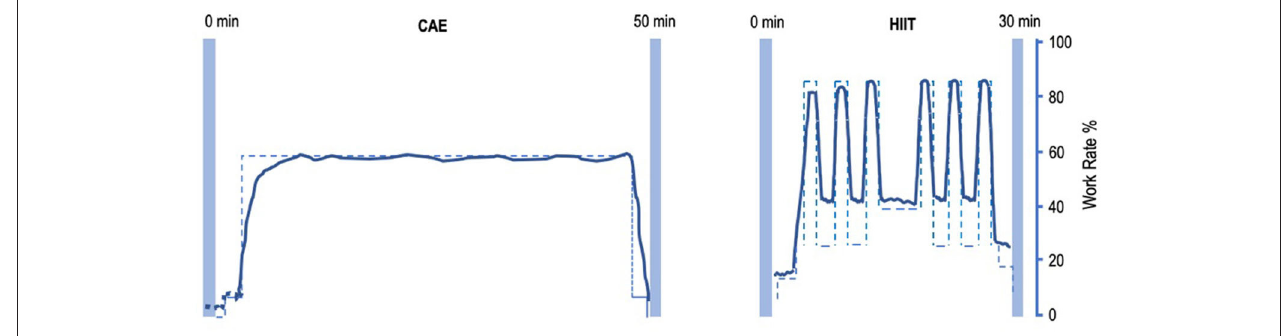
FIGURE 1 | Intensity-work rate plot for CAE and HIIT session. Left: intensity-work rate plot for a 50-min CAE intervention session. Right: intensity-work rate plot for a 30-min HIIT intervention session. CAE training intensity will be at about 55% W-max, HIIT will alternate between training intensity 35% W-max during low-intensity intervals and > 85% W-max at high-intensity intervals. CAE, continuous aerobic exercise; HIIT, high-intensity interval